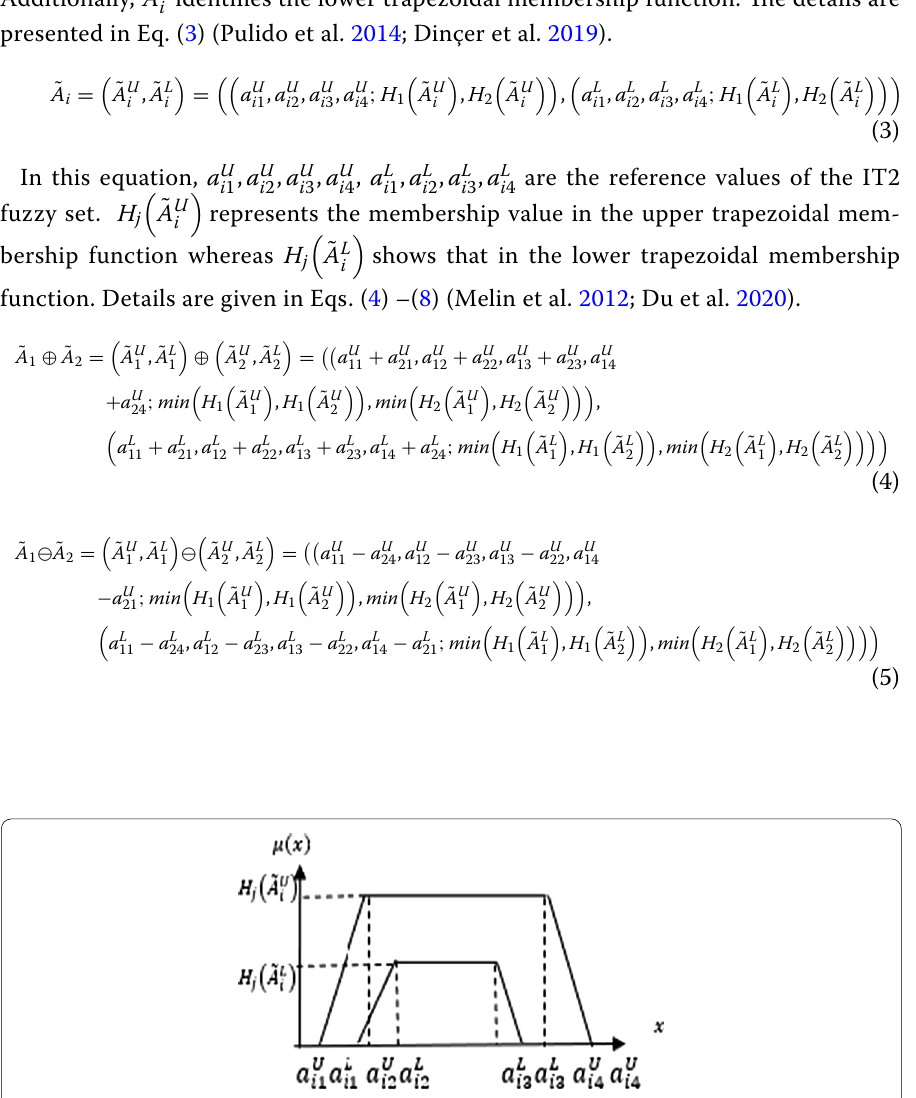
Fig. 2 The trapezoidal membership function of the interval type-2 fuzzy